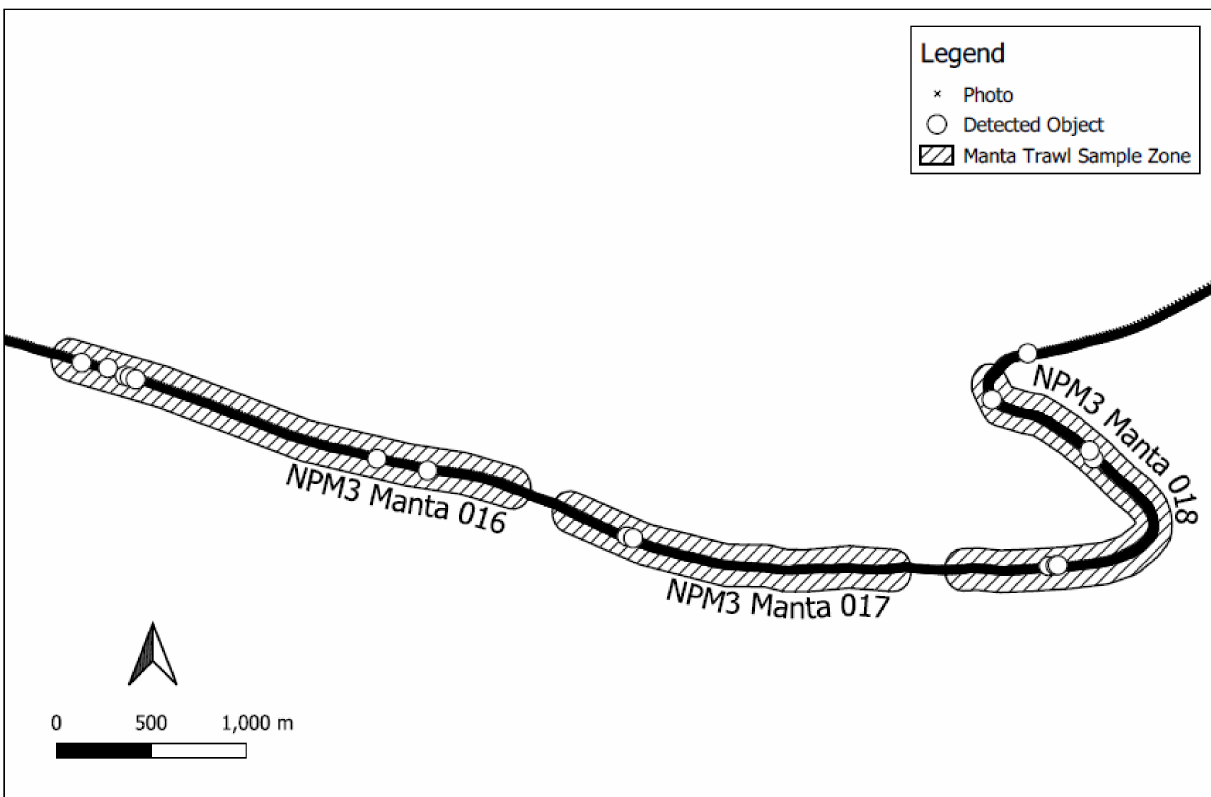
Figure 5. Map highlighting the comparison of three example Manta trawl samples with camera surveys. The black line indicates the camera GPS tags, a concatenation of individual markers. Each black hatched areas indicate a Manta Trawl Sample Zone, a 100 m (each side) buffer around each Manta trawl trajectory. White bubbles indicate the locations of unique identified floating macroplastic objects. The GIS processing attributes the number of detected objects to each sample zone as well as the total number of photographs